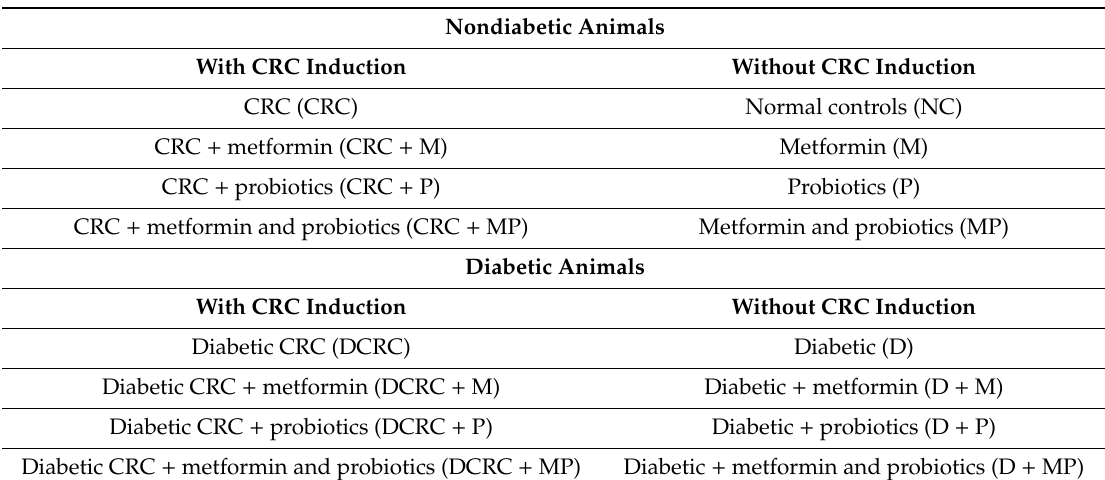
Table 2. Experimental Design. Balb / c Male Mice were Divided into two Main Groups, Nondiabetics and Diabetics, and Two Other Subgroups, CRC and non-CRC. They were Then Divided According to the Di ff erent Treatment Combinations to form a Total of 16